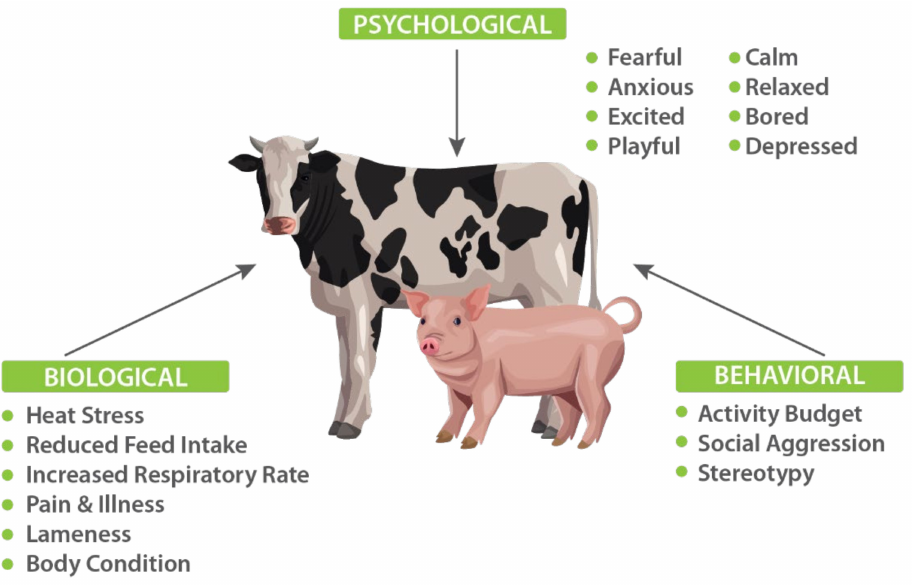
Figure 5. A framework for animal welfare assessment incorporating multimodal robust